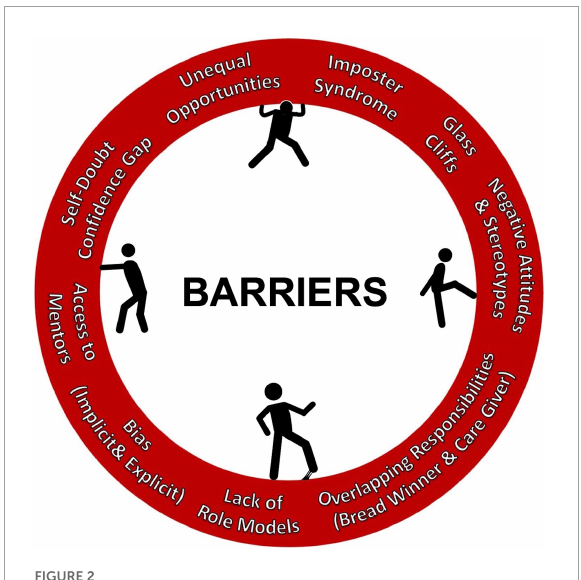
FIGURE2 Barriers to advancement for women in CT surgery and heart failure